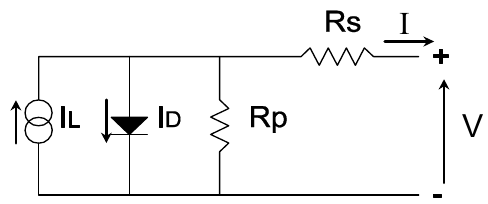
Figure 1. One-diode model of a photovoltaic (PV) cell including the series and shunt resistances.